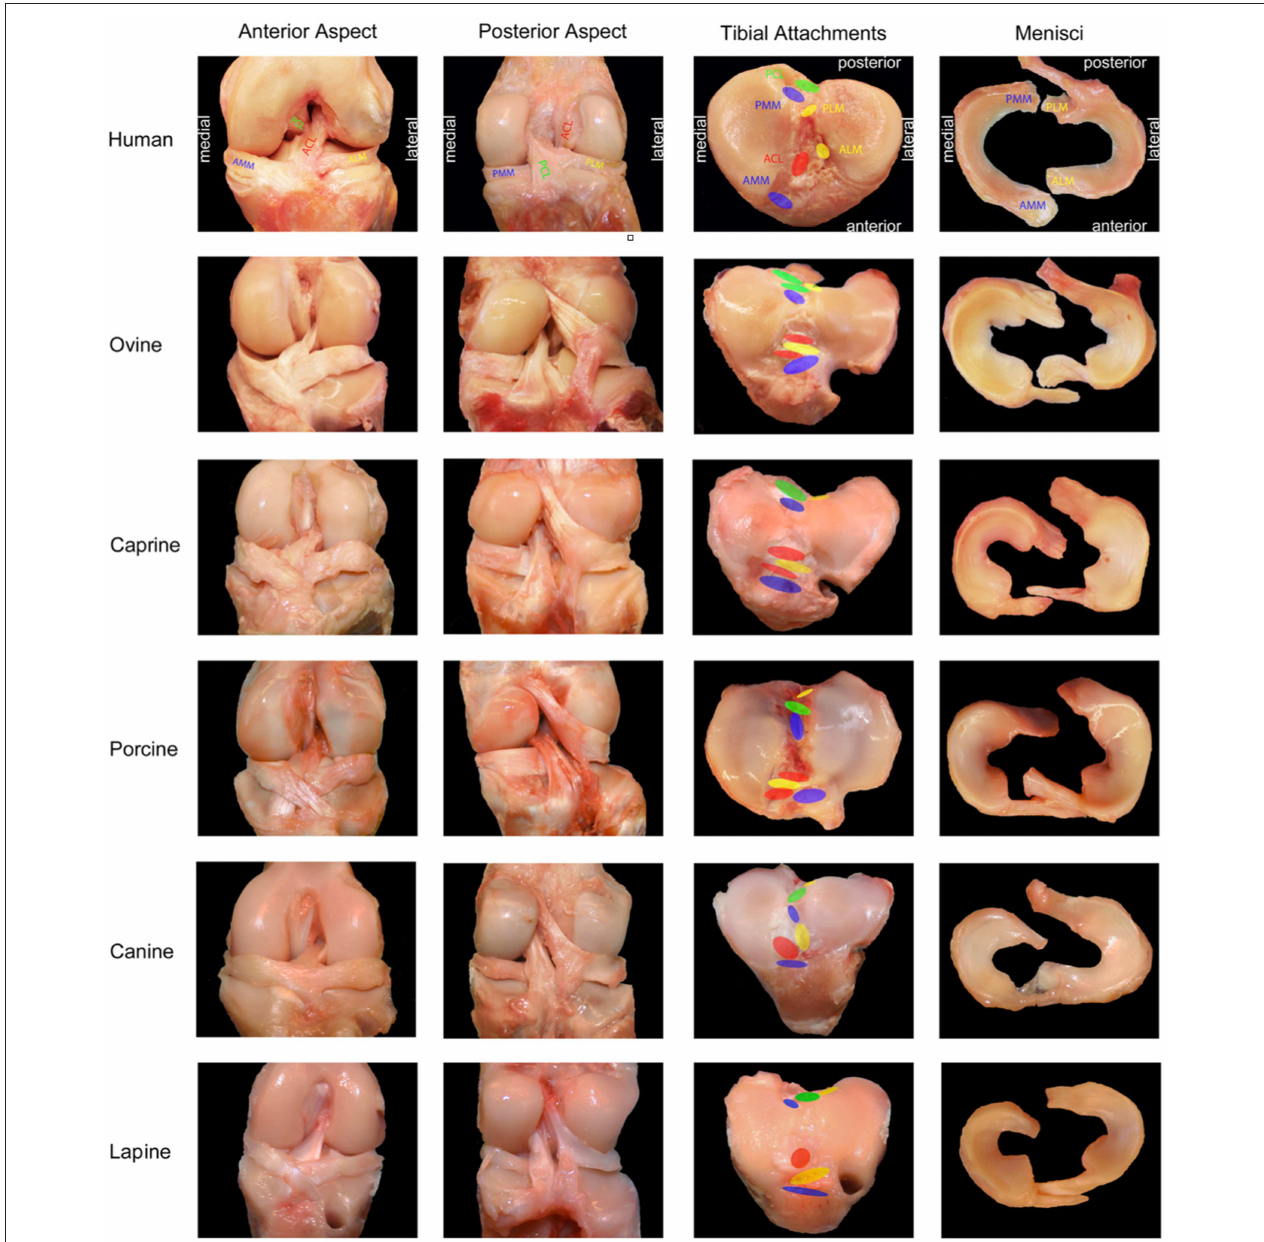
FIGURE 1 | Photographic comparison of anatomic features of the knee between humans and large animal models. ACL, anterior cruciate ligament; PCL, posterior cruciate ligament; AMM, anterior horn, medial meniscus; ALM, anterior horn, lateral meniscus; PMM, posterior horn, medial meniscus; PLM, posterior horn, lateral meniscus. Adapted and reprinted from Proffen et al. (3). Copyright (2012) with permission from